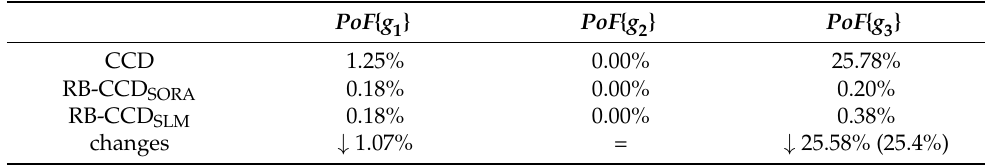
Table 3. Probabilities of failure using MCS with n = 100,000 samples.